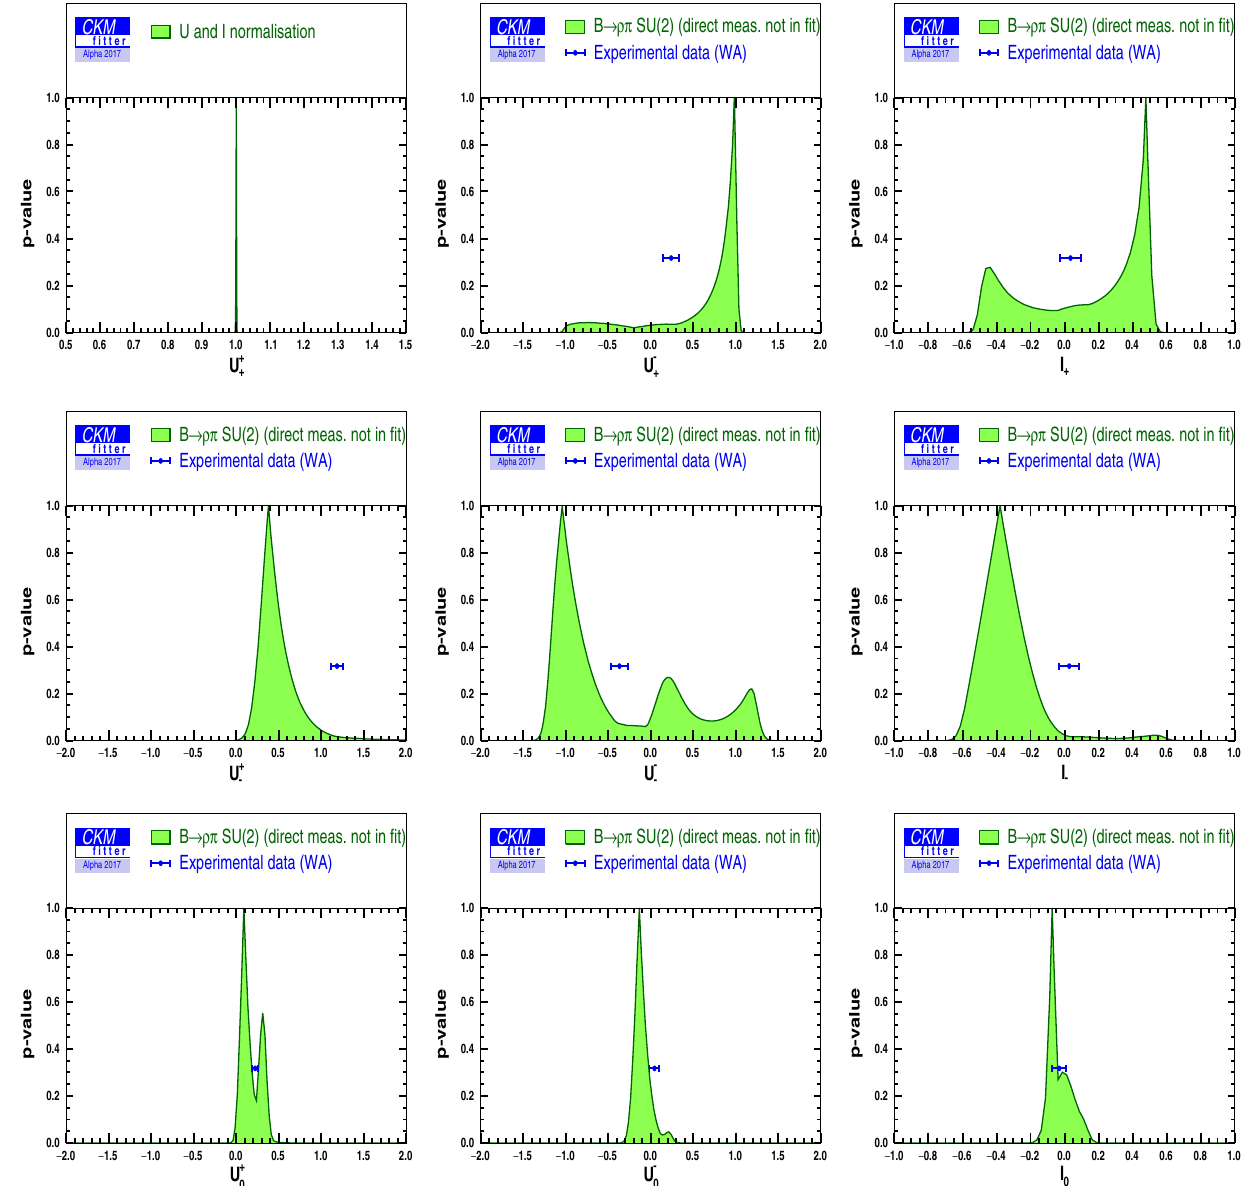
Fig. 31 SU ( 2 ) isospin constraint on the Q2B-related coefficients U and I describing the B 0 → (ρπ) 0 intermediate states. The upper left figure corresponds to the overall normalisation, U + + = 1. For each observable, the direct measurement, not included in the fit, is indicated by an interval with a dot